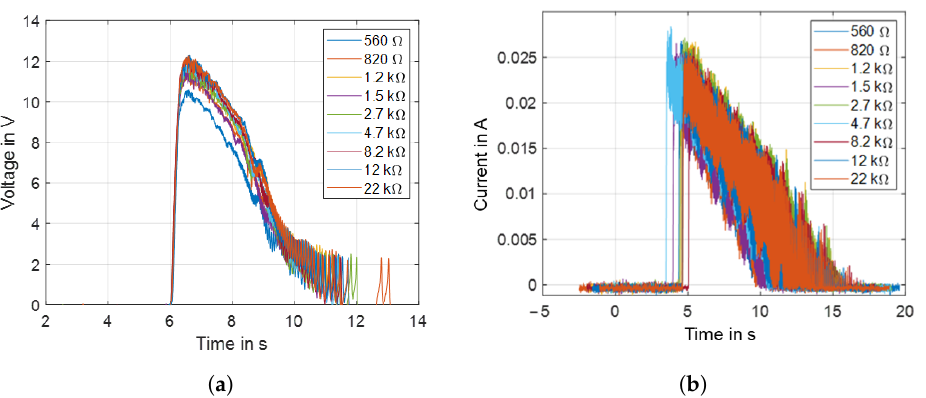
Figure 12. ( a ) Open circuit voltage output, ( b ) charging current to the